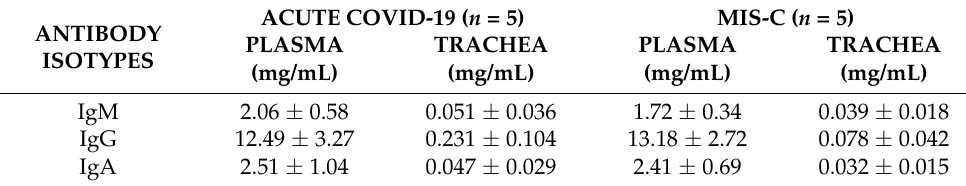
Table 1. Amount of total IgM, IgG, and IgA in undiluted plasma and tracheal samples from pediatric COVID-19 and MIS-C